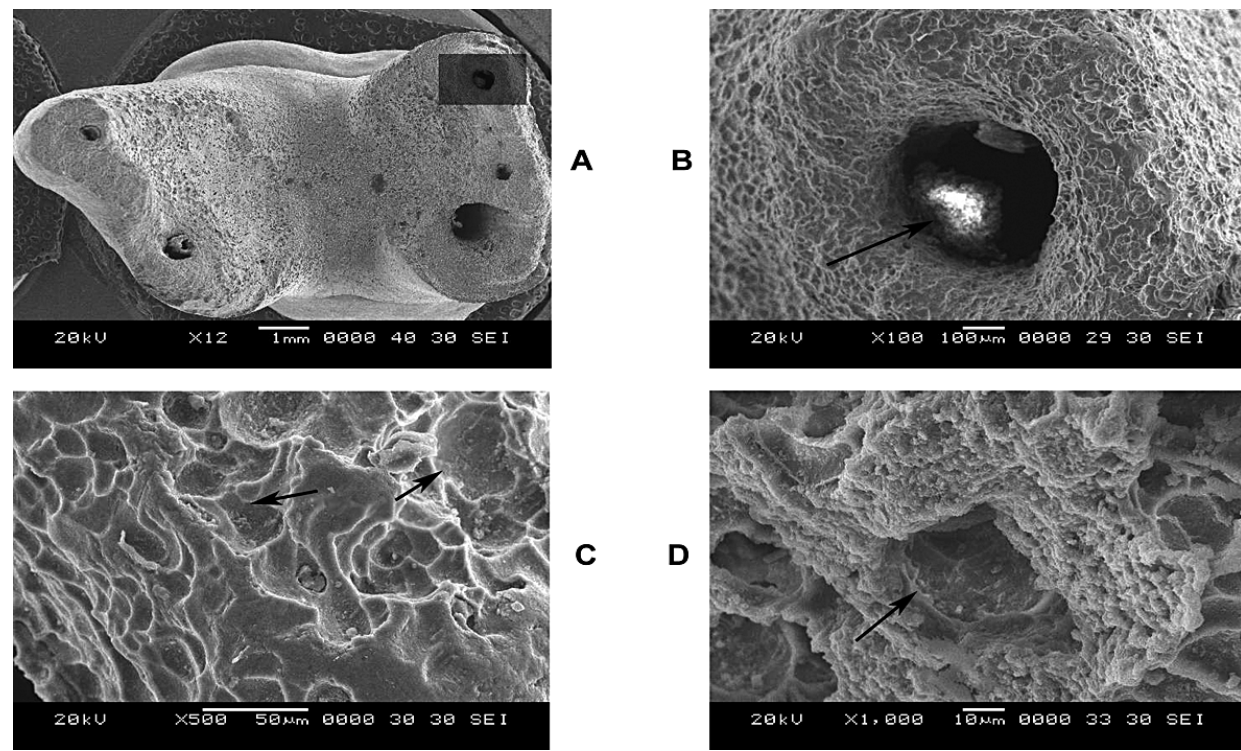
FIGURE 1 (A-D) - Root resorption of a primary molar at 12x, 100x, 500x and 1000x